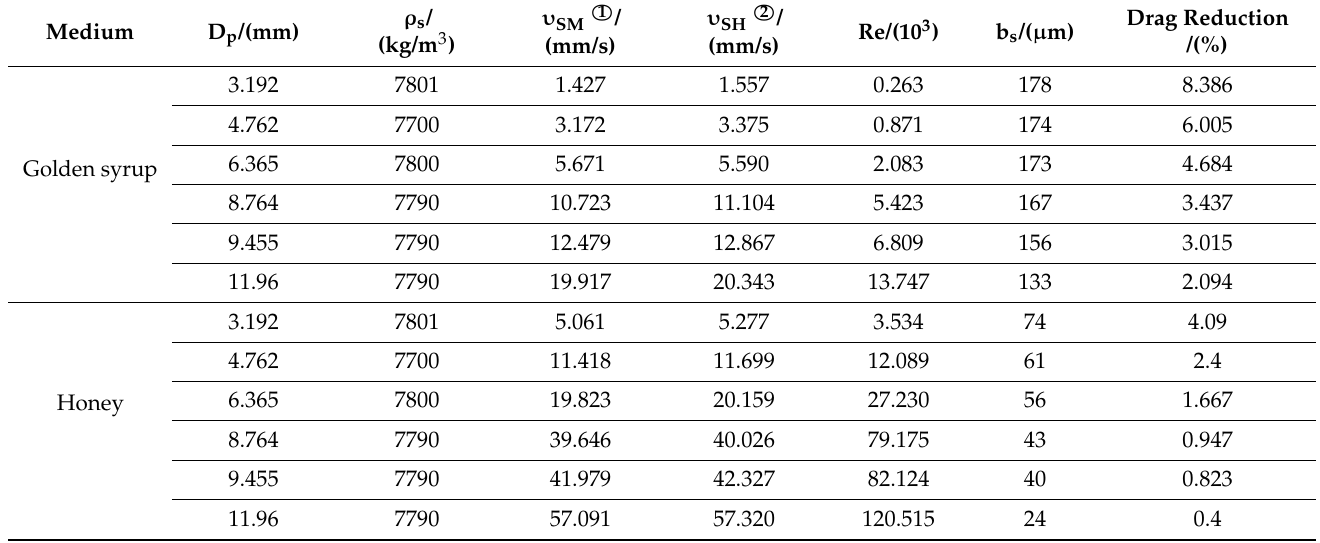
Table 2. Flow drag reduction in honey and golden syrup. Reprinted with permission from Ref [107]. Copyright 2017